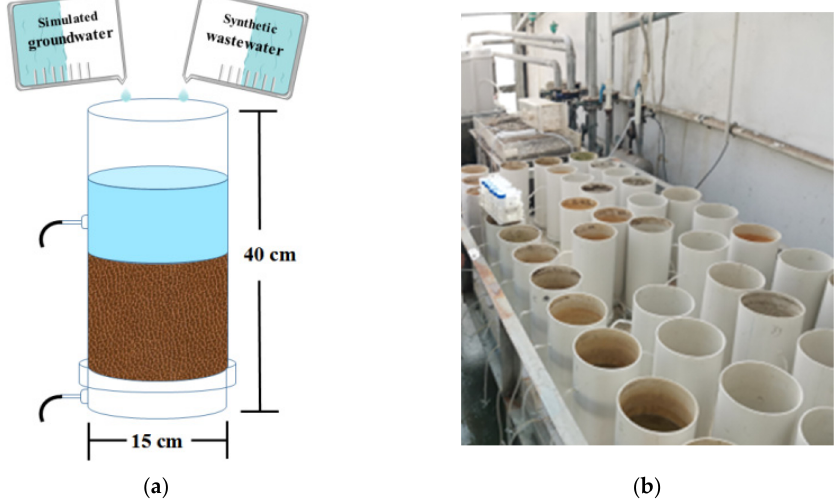
Figure 1. Schematic diagram ( a ) and photo of the CW microcosms ( b ).